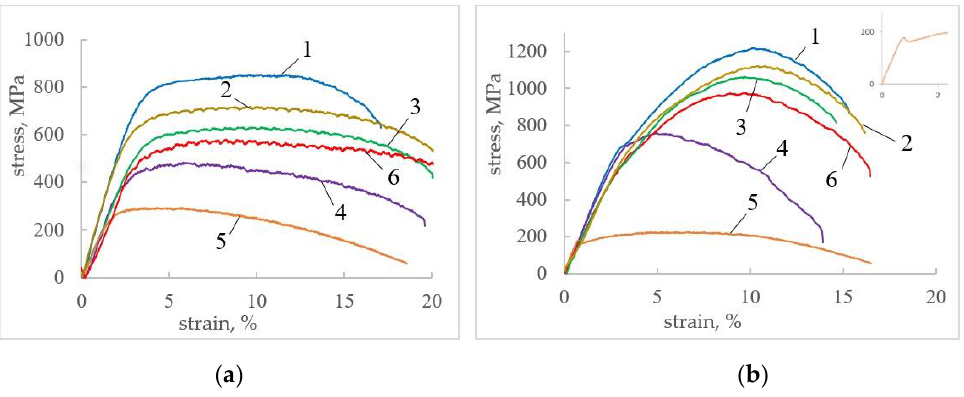
Figure 8. Stress-strain curves for CG ( a ) and UFG ( b ) titanium: 1—without current; 2—j = 30 A/mm 2 , τ = 100 µ s; 3—j = 30 A/mm 2 , τ = 1000 µ s; 4—j = 60 A/mm 2 , τ = 100 µ s.; 5—j = 60 A/mm 2 , τ = 500 µ